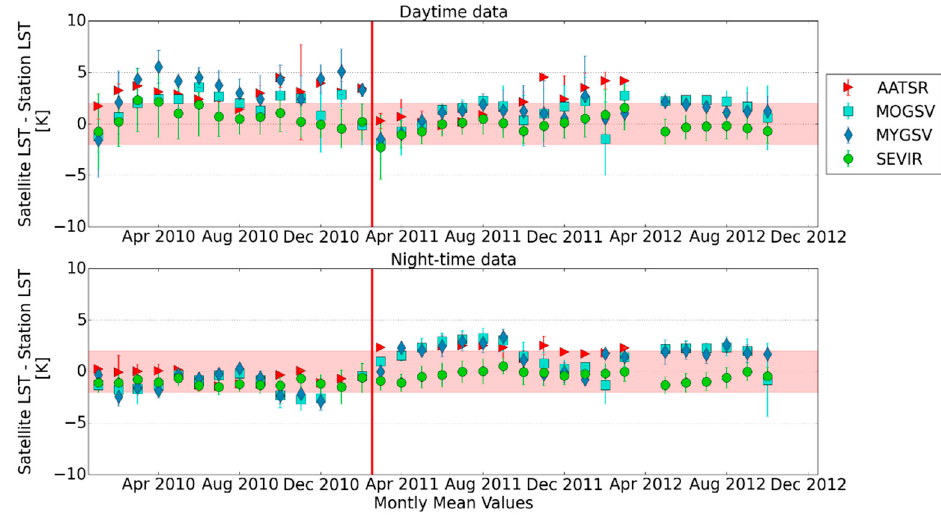
Figure 11. Monthly median accuracies (satellite LST–station LST) over KAL_R and KAL_H stations for the years 2010–2012. The upper plot shows daytime and the lower night-time data. The ranges shaded in red indicate the ± 2.0 K accuracy range and the vertical red bar the time, when KAL_R was replaced by KAL_H in February 2011.